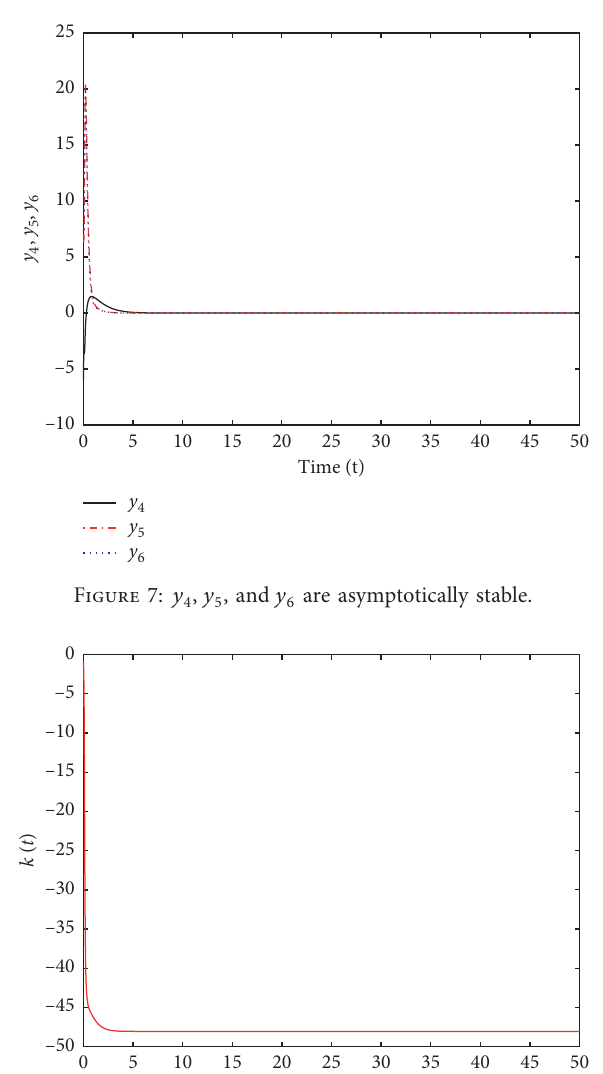
,y , and y are asymptotically stable. 1 2 3